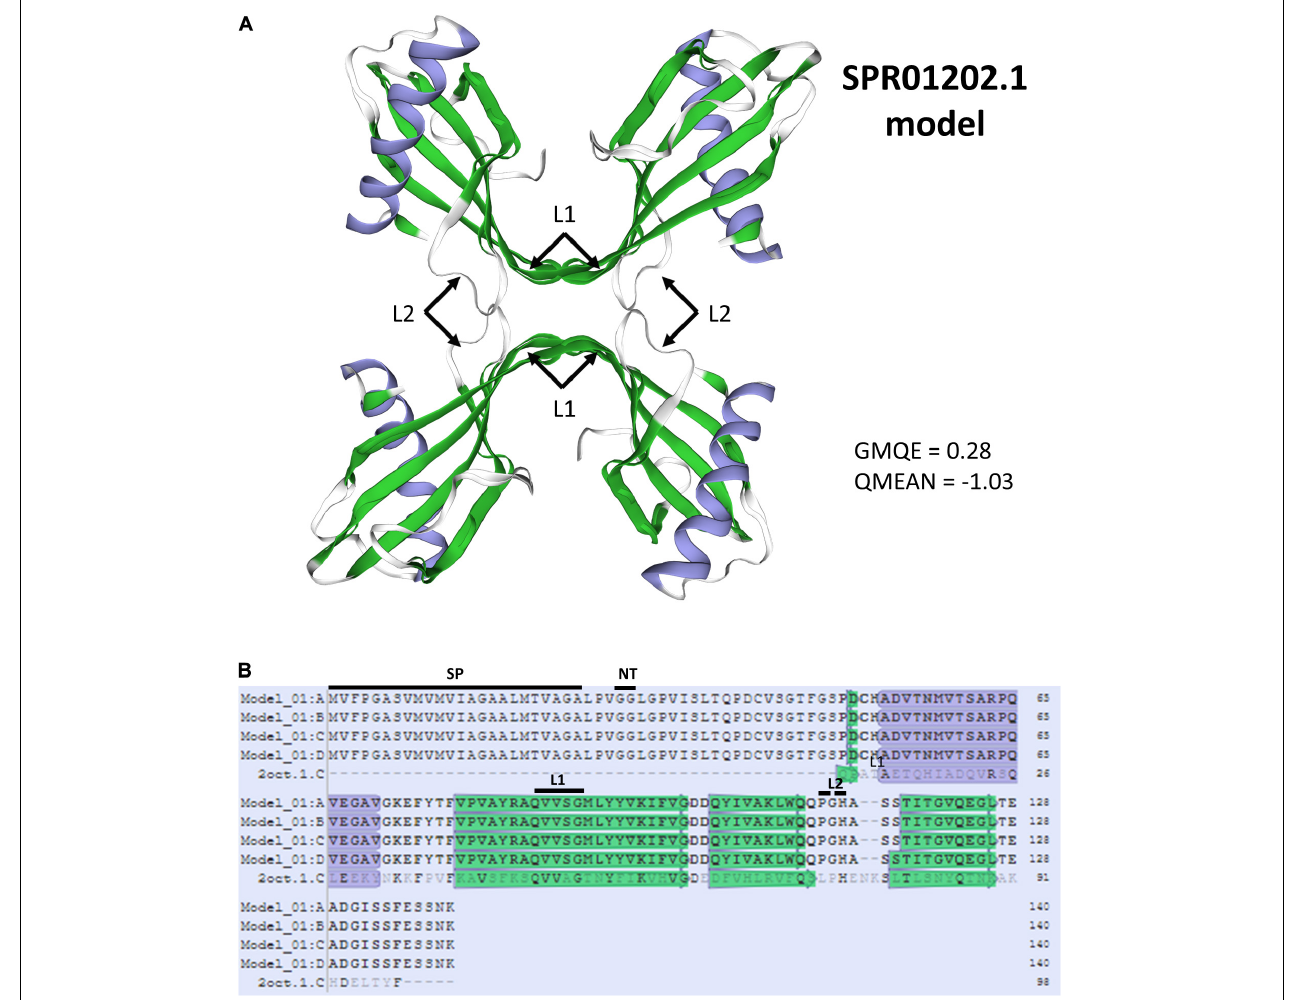
FIGURE 4 | Predicted 3D structure of a Cystatin Protease Inhibitor. (A) The cystatin homo-tetramer was predicted using Stefin-B (Cystatin-B, STML ID:2oct.1.C) using Swiss-model. A Global Model Quality Estimation (GMQE) score closer to 1 represents more accuracy in the models, and a QMEAN value above –4 is indicative of good quality of the structure (https://swissmodel.expasy.org/docs/help). Alfa helices are depicted in purple and beta sheets and loop regions are in green; the four L1 and the four L2 loop regions are indicated. (B) Multiple sequence alignment of the four predicted monomers forming the tetramer with the template Stefin-B. Alpha helices are highlighted in purple and beta sheets are in green. The three conserved sites that form a complex with papain: the N-terminal Trunk (NT), loop 1 (L1), and loop 2 (2), are also